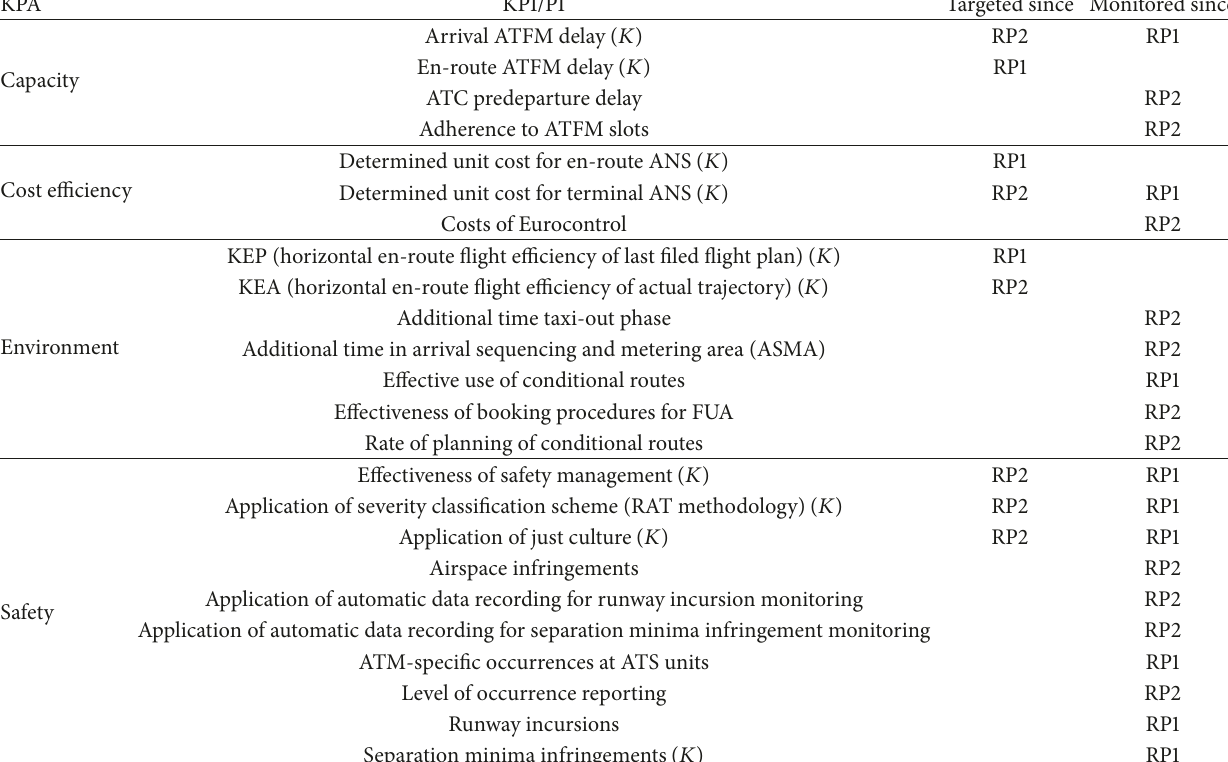
Table 1: KPAs and KPIs/PIs adopted by the SES Performance